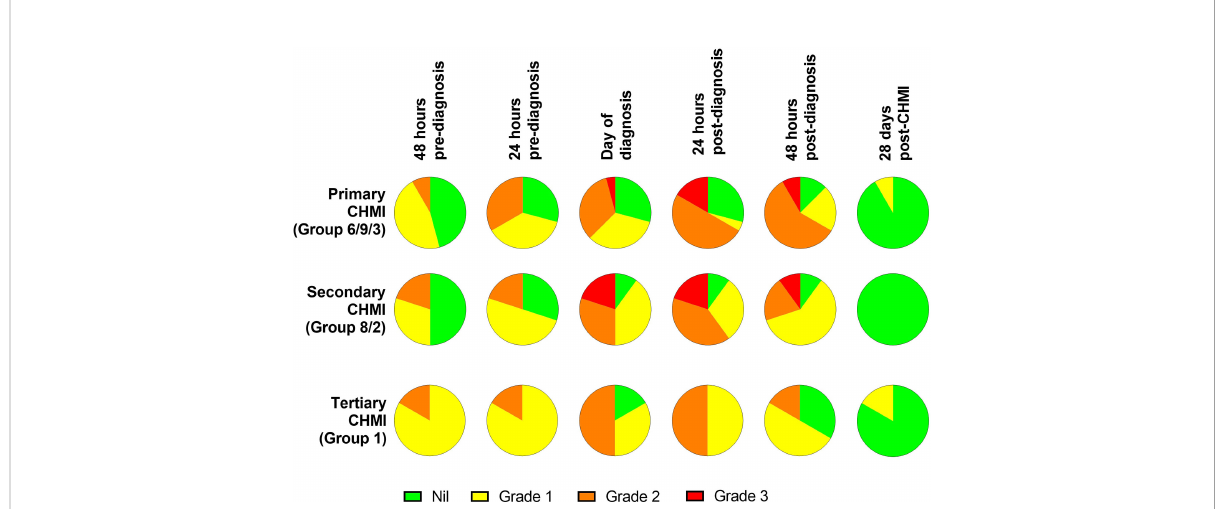
FIGURE 3 Symptom evolution during repeated P. falciparum blood-stage CHMI. The maximum severity of any solicited systemic adverse events (AE) recorded at the indicated time points during the CHMI period for each participant for primary (n=24), secondary (n=10) and tertiary (n=6) CHMI.